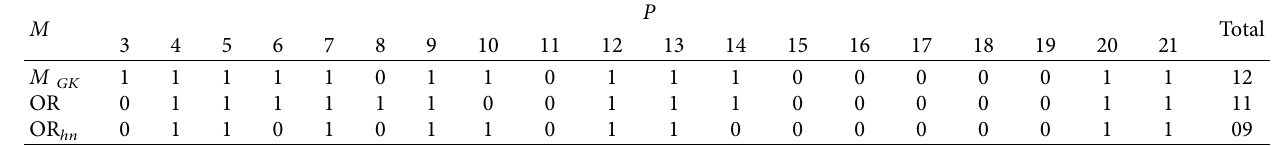
Table 7: Matrix describing the three measures according to the 19